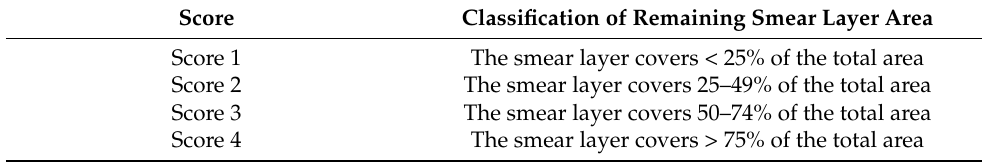
Table 1. Score and classification of the remaining smear layer.